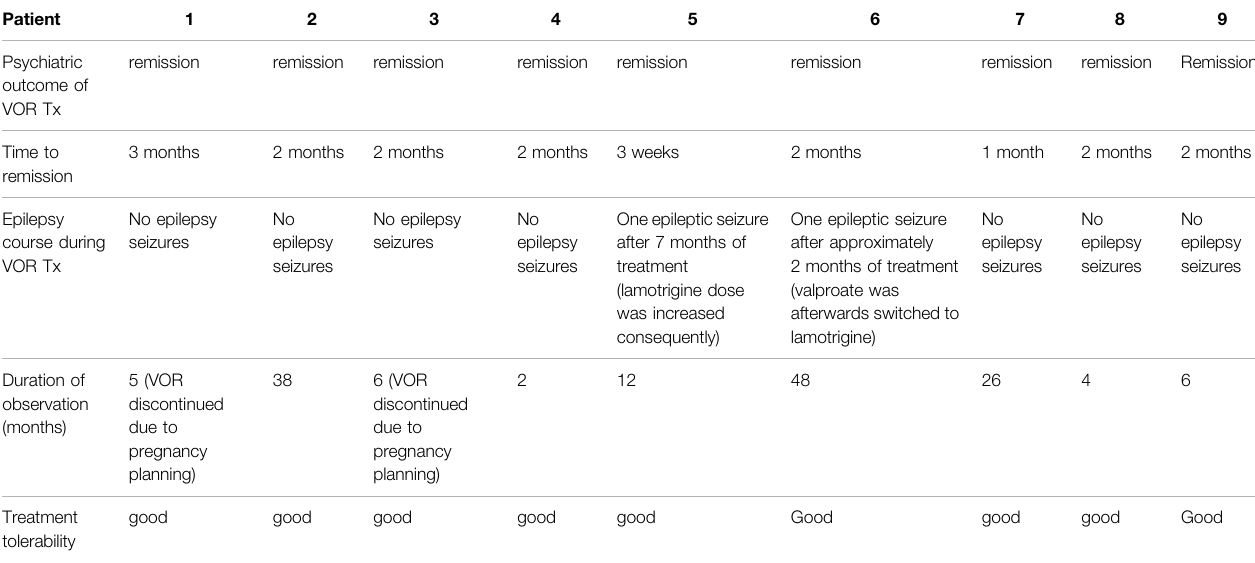
TABLE 2 | Effectiveness and tolerability of vortioxetine treatment in nine presented cases.